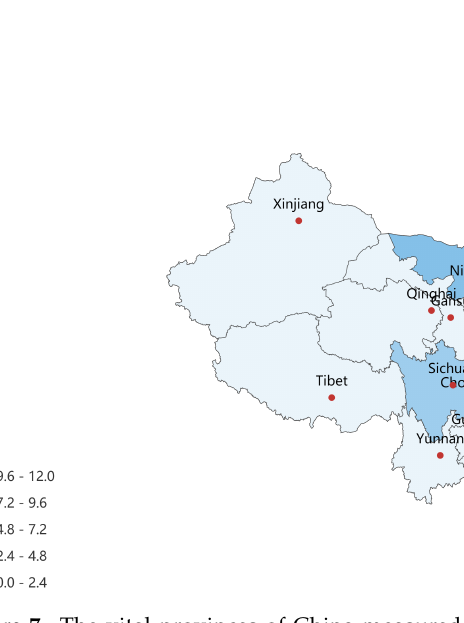
Figure 7. The vital provinces of China measured by the proposed MINE algorithm, where Inner Mongolia, Sichuan, Zhejiang and Guangdong hold more importance in the graph of the adjacencies (formed by 34 vertices and 73 edges). By performing with the proposed MINE algorithm, we can find that Inner Mongolia holds the maximum importance in the derived network model, which may result from its huge span in longitude (97 ◦ 12 (cid:48) E–126 ◦ 04 (cid:48) E) and adjacencies to eight other provinces, i.e., Gansu, Ningxia, Shaanxi, Shanxi, Hebei, Liaoning, Jilin and Heilongjiang. Zhejiang is the second influential province measured by the MINE algorithm, which suggests its vital position in the southeast of China.